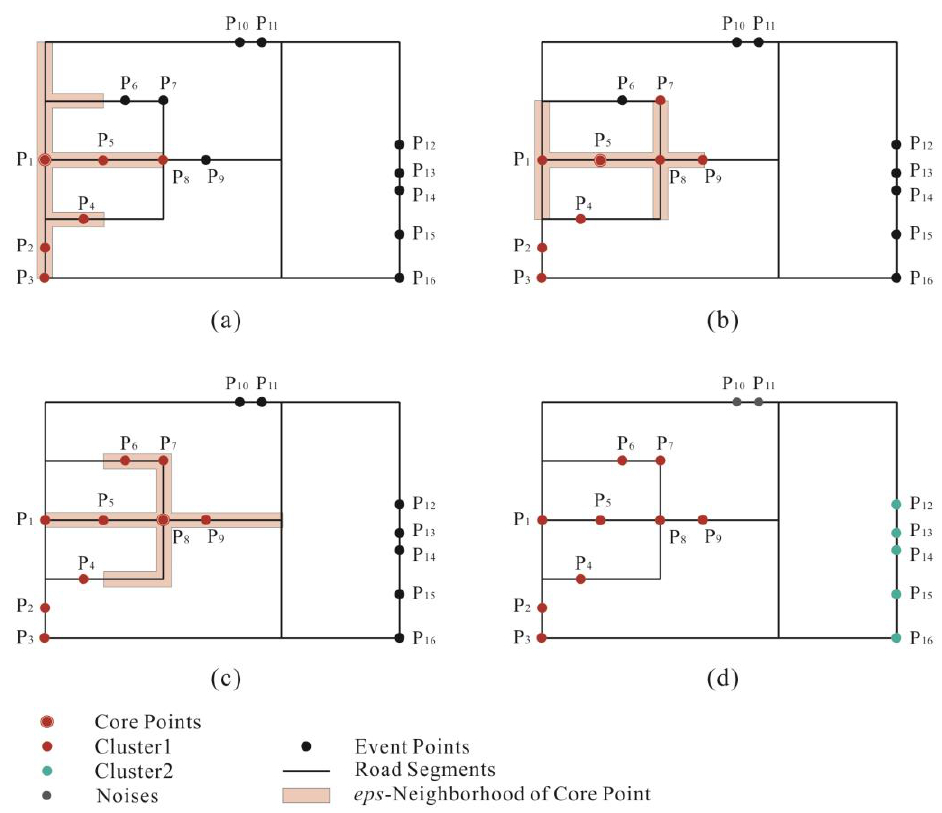
Figure 6. The core points in cluster gradually brought the border points into the cluster: ( a ) P 1 brought P 5 , P 2 , P 4 , P 8 , and P 3 to cluster 1; ( b ) P 5 brought P 7 and P 9 to cluster 1; ( c ) P 8 brought P 6 to cluster 1. The points of the simulated dataset eventually formed two clusters, and two points became noises, as shown in ( d